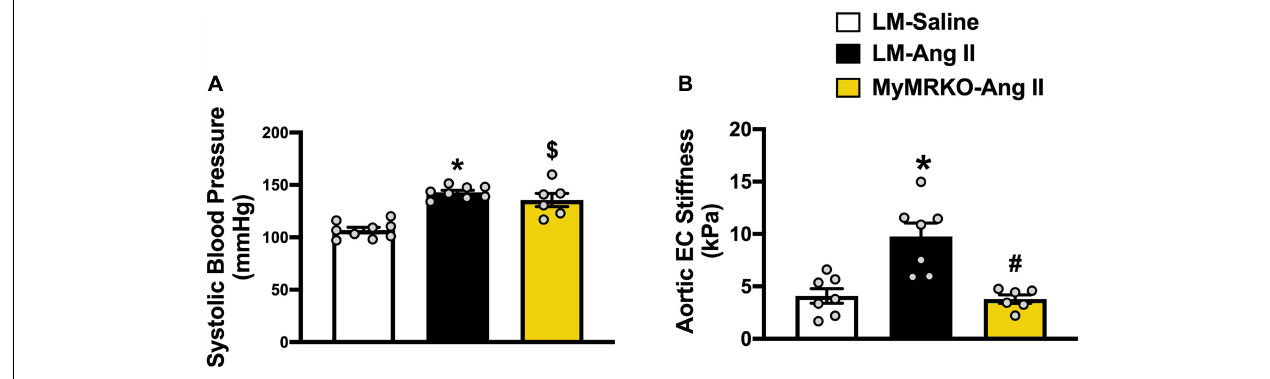
FIGURE 1 | Ang II-induced aortic stiffening is ameliorated by myeloid cell MR deletion. Systolic blood pressure (A) and ex vivo assessment of aortic endothelial stiffness by atomic force microscopy (B) . * p ≤ 0.05 LM-Ang II vs. LM-Saline; # p ≤ 0.05 LM-Ang II vs. MyMRKO-Ang II; $ p ≤ 0.05 MyMRKO-Ang II vs. LM-Saline. n = 6–9 for all groups. EC, endothelial cell; LM, littermate; Ang II, angiotensin II; MyMRKO, myeloid mineralocorticoid receptor